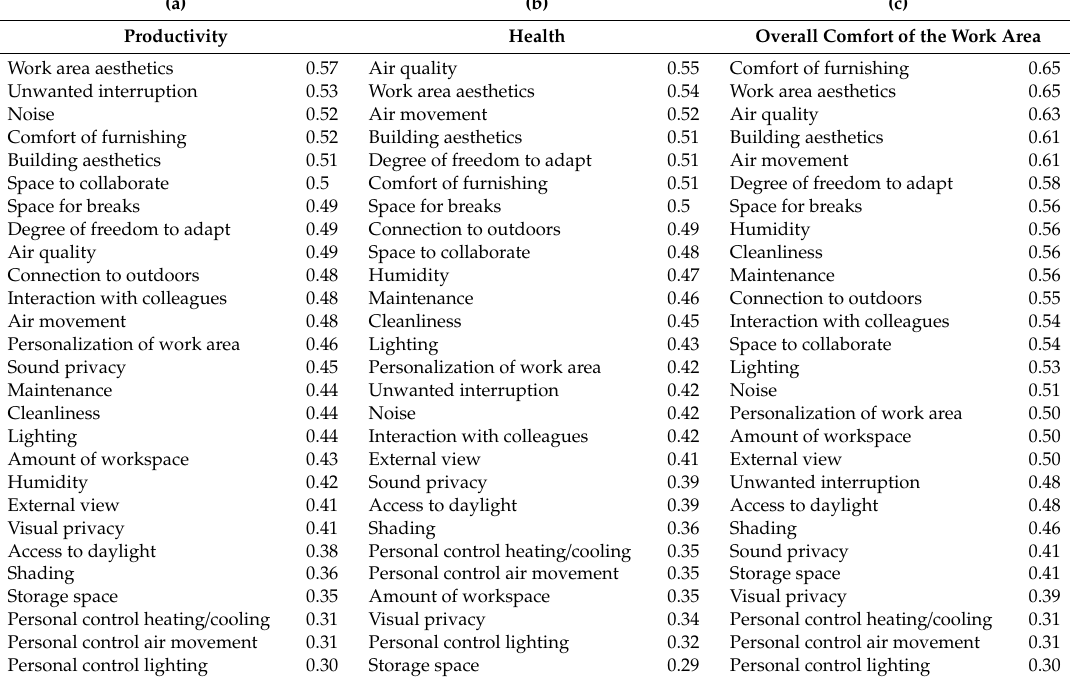
Table 3. Pearson correlation coe ffi cient ( ρ ) computed for: ( a ) perceived productivity; ( b ) health; ( c ) overall comfort of the work area. The 28 features are sorted in descending order according to the value of ρ .